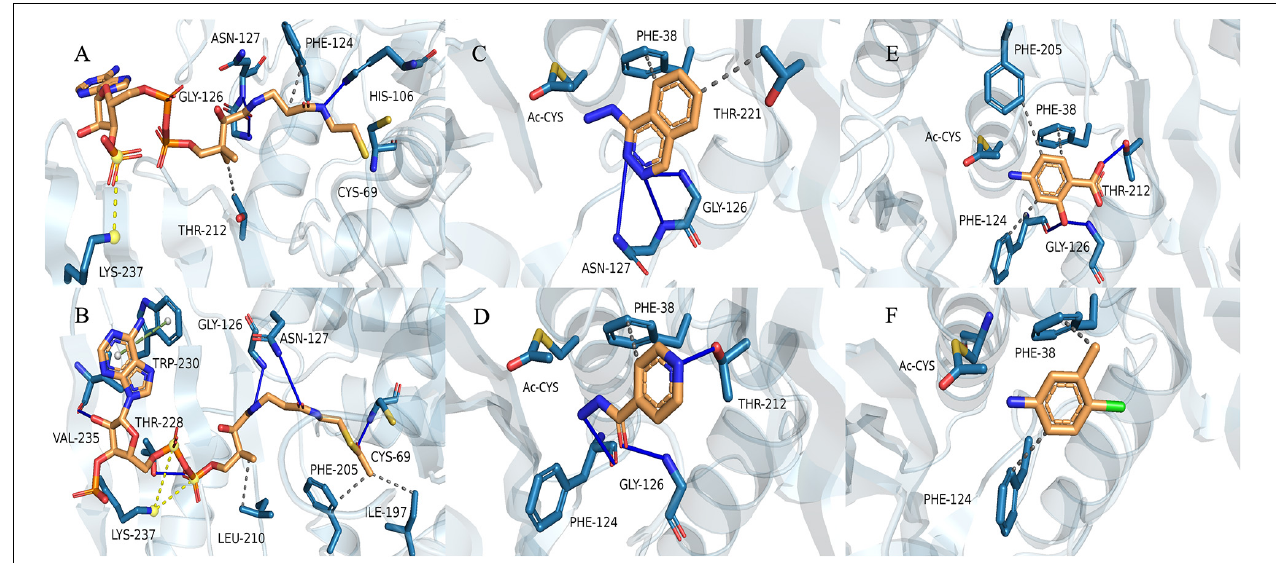
FIGURE 8 | Binding model of CoA with (VIBVN)NAT. (A) The binding model of AcCoA with (VIBVN)NAT (B) and the binding model of (VIBVN)NAT with four aromatic amine substrates: (C) HDZ, (D) INH, (E) 4-AS, and (F) 4-C3ME. The solid blue lines represent hydrogen bonds, the gray dotted lines represent hydrophobic interactions, the yellow dotted lines represent salt bridges, and the green dotted lines represents pi-pi